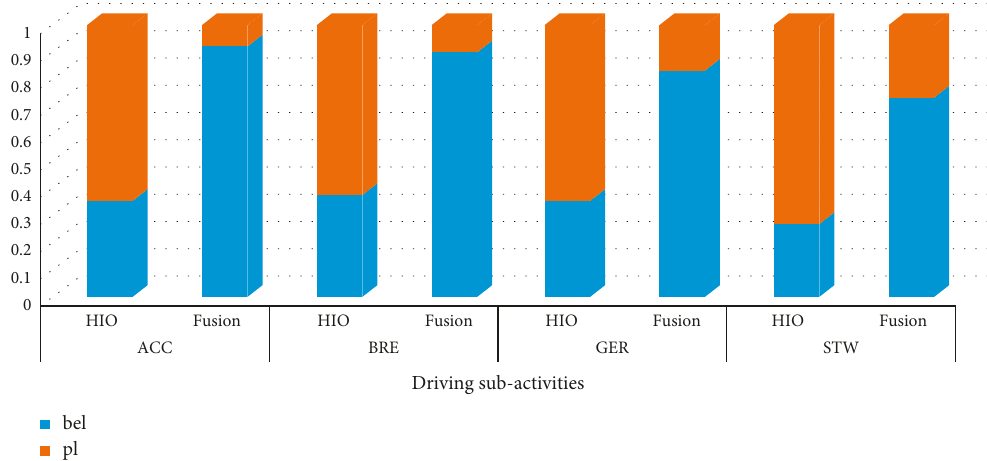
Figure 4: Stacked bel and pl functions for each DSA in the evening